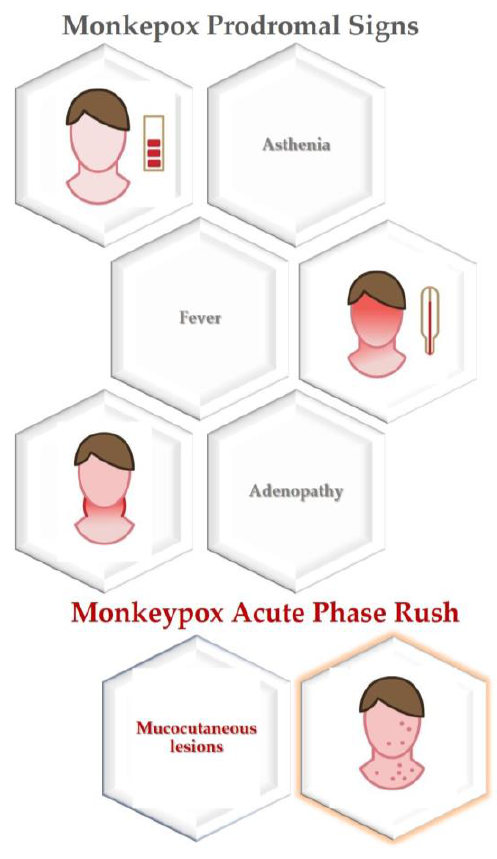
Figure 2. Monkeypox general clinical presenting features.